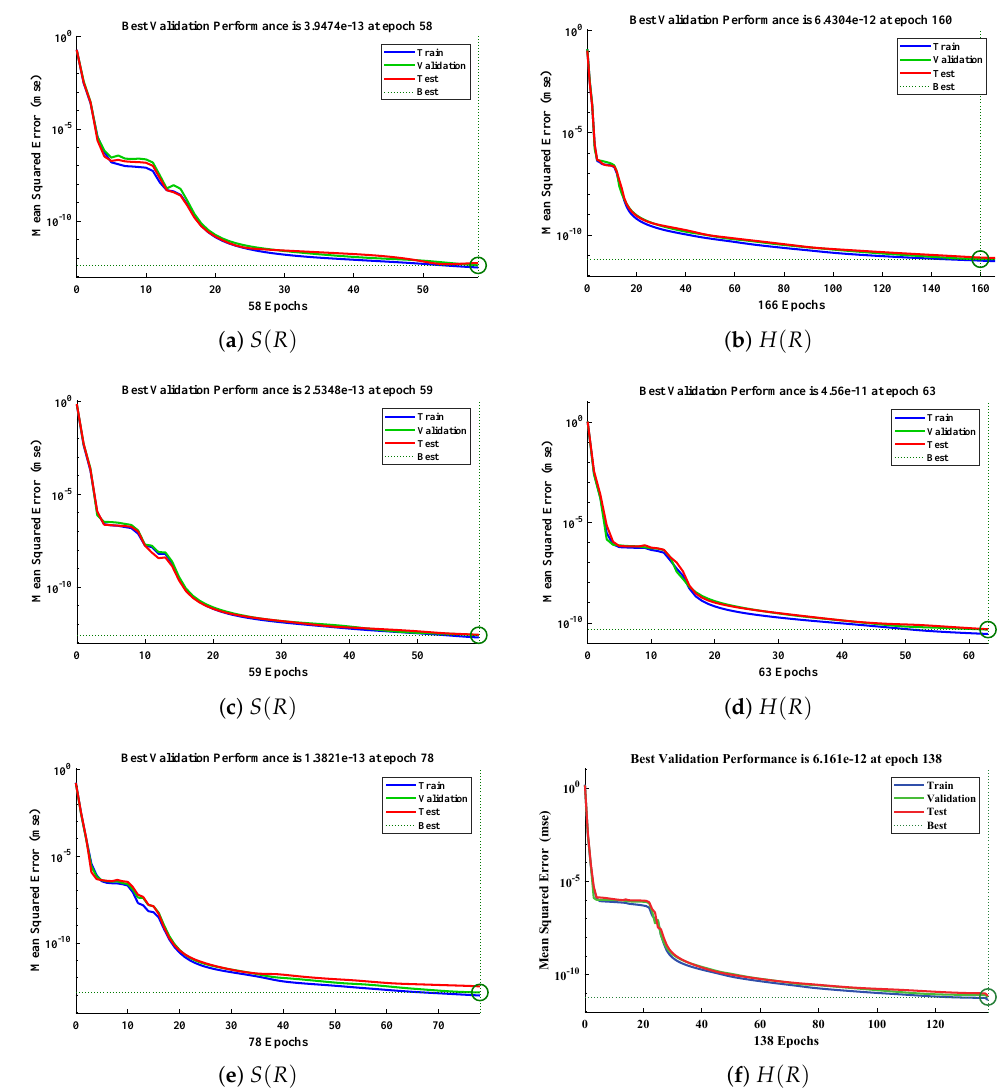
Figure 5. Performance of NNs–LM technique in terms of mean square error for ( a , c , e ) dimensionless concentration of substrate and ( b , d , f ) hydrogen peroxide of scenario